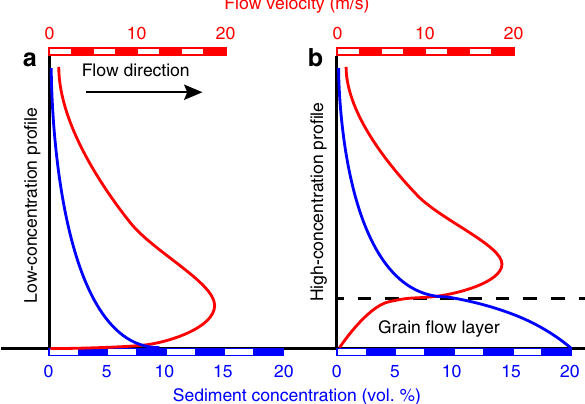
Fig. 5 Conceptual velocity and concentration pro fi les vertically within a submarine gravity fl ow. a Low depth-averaged sediment concentrations result in a progressive increase in concentration towards the fl ow base. The shape of this pro fi le is governed by the downward settling of grains and the upward mixing of turbulence. b At higher depth-averaged concentrations the fl ow strati fi es into a hyperconcentrated basal grain fl ow layer overlain by a more dilute upper layer. Turbulence is suppressed in the basal layer and particles maintained in suspension via grain collisions and hindered settling effects. Our estimates of depth-averaged concentration indicate the 1929 fl ow probably had a high-concentration pro fi